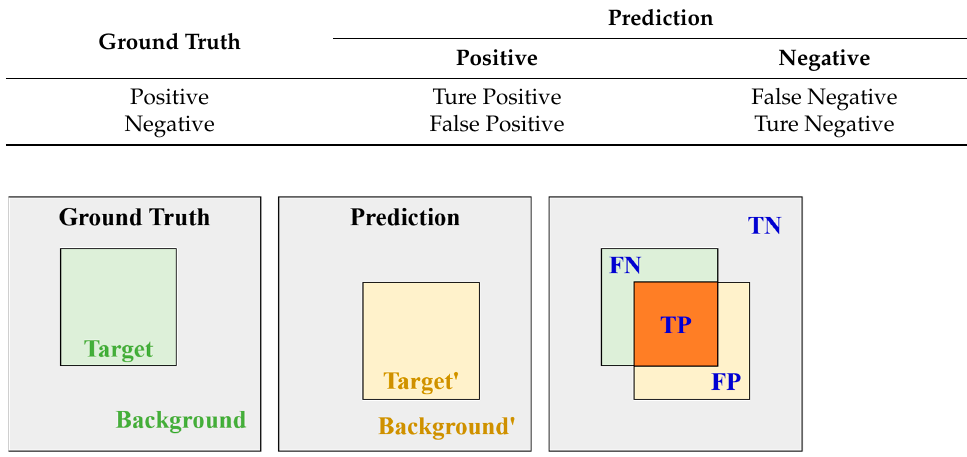
Figure 7. The schematic diagram of TN , TP , FN , and FP in the analysis of image segmentation. In the comparative test, four evaluation indexes [44–47], i.e., pixel accuracy ( PA